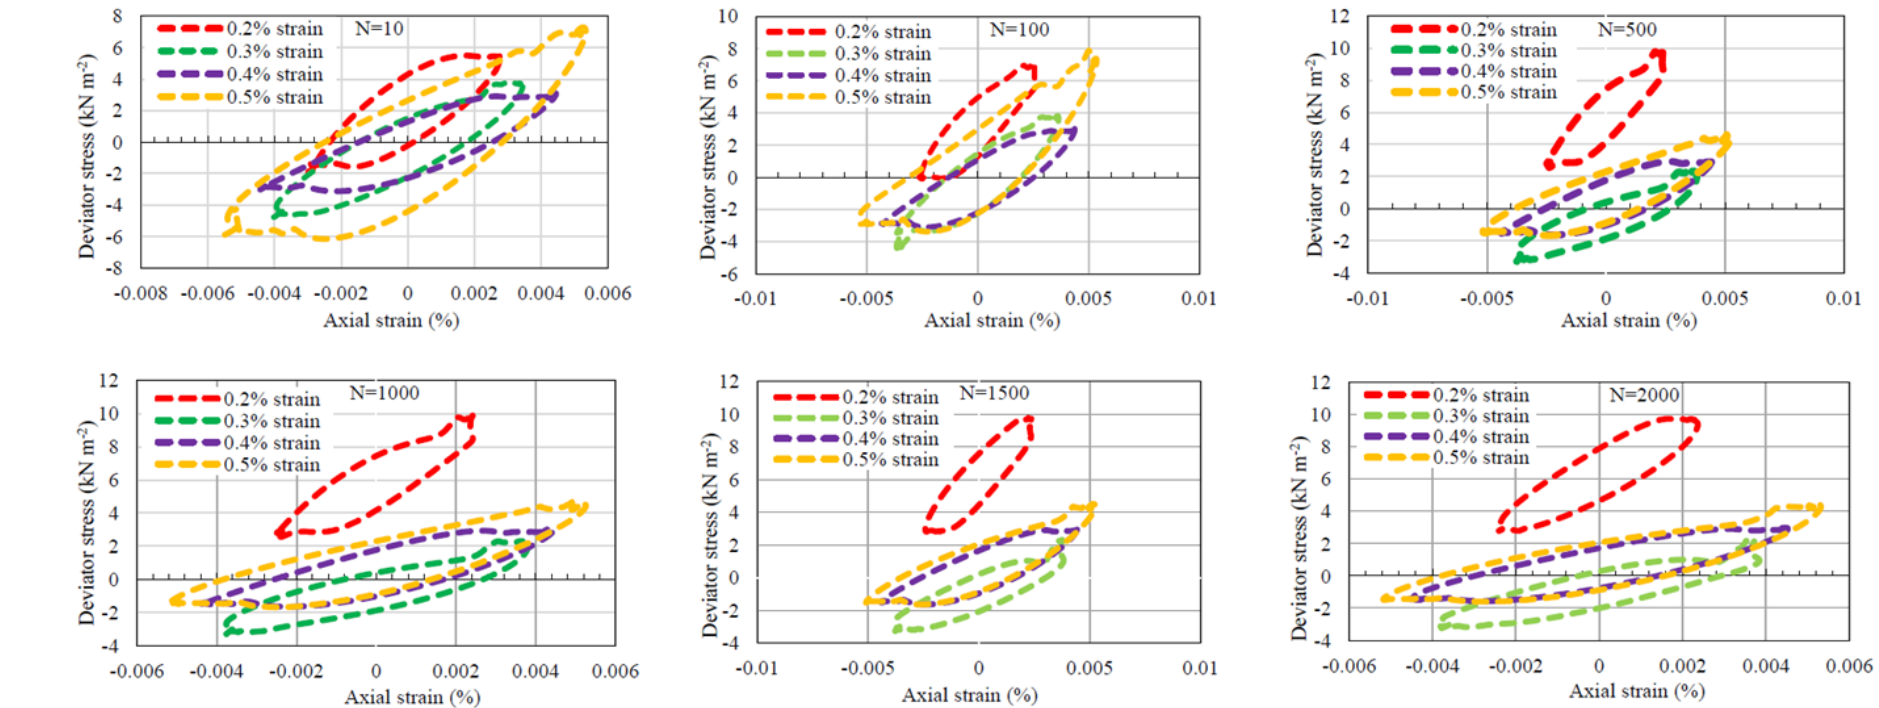
Figure A5. Sample graphs showing degradation of peat under cyclic loading at 0.2, 0.3, 0.4 and 0.5 % axial strains in varying cylces of loading ( N ) ranging from 10 to